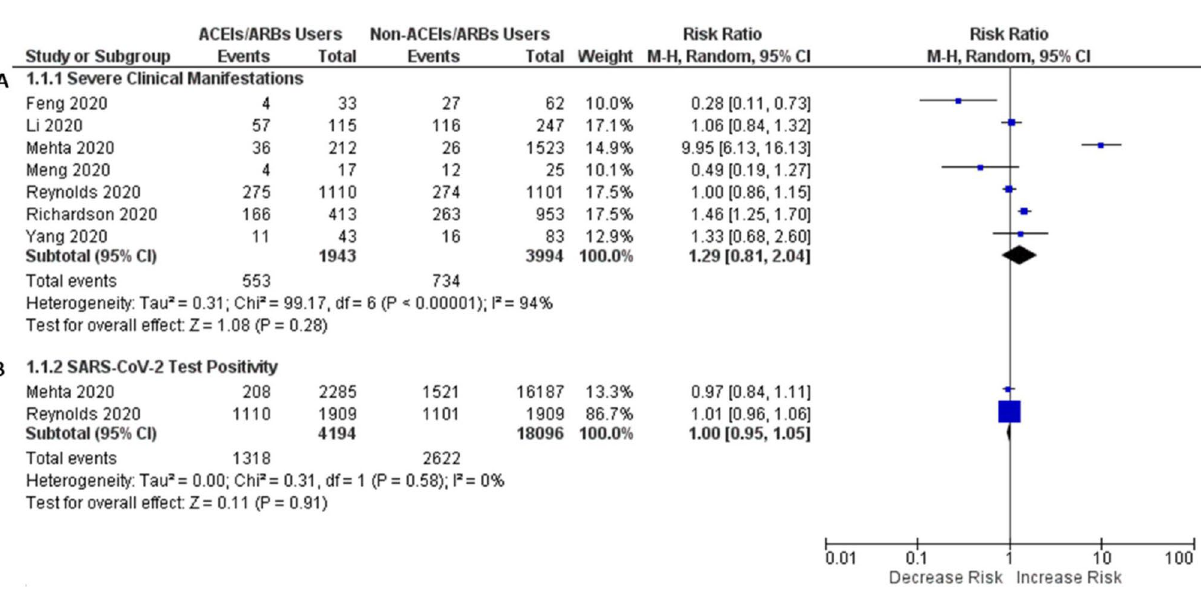
Figure 2. Forest plot of ACEIs/ARBs users against non-users of ACEIs/ARBs on the risk of mortality in patients with COVID-19.